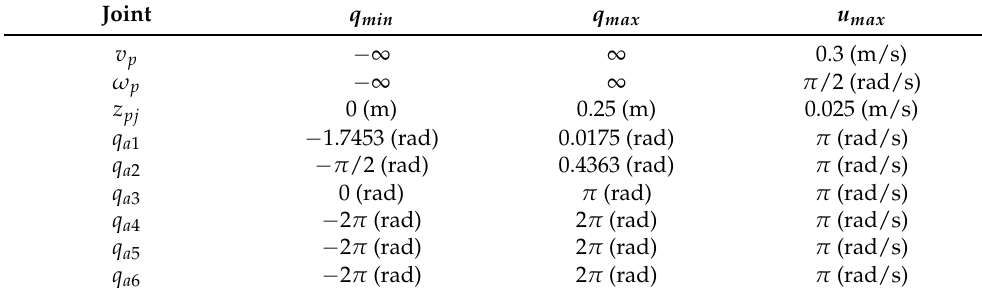
Table 2. Joints physical